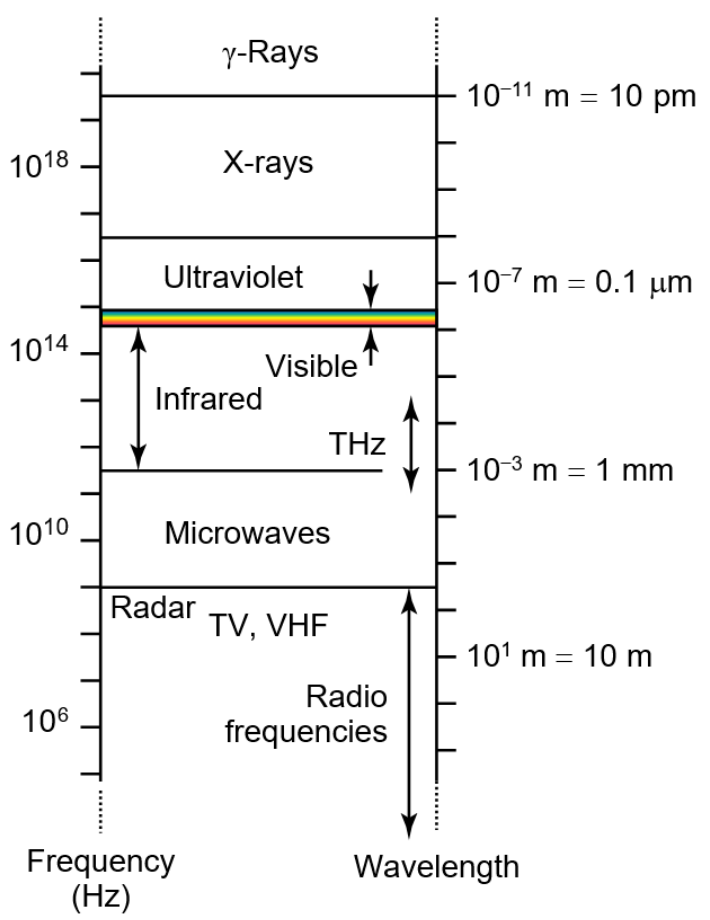
Figure 1. Overview of the electromagnetic wave spectrum. Adapted from [11].